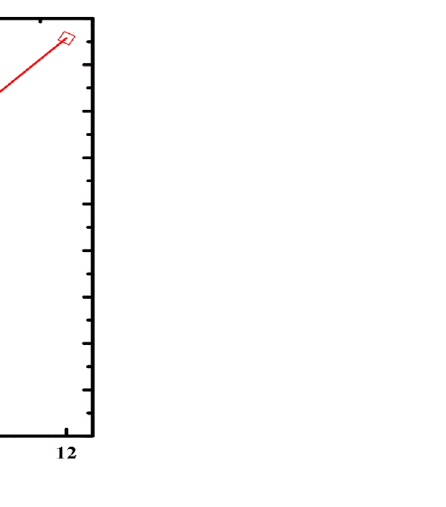
Figure 8. Effect of density ratio variation on the system’s